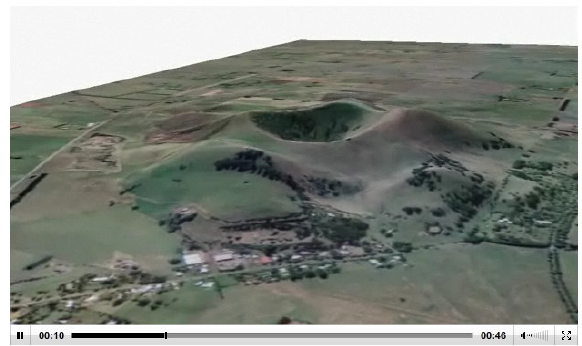
Figure 5. Mt Noorat landscape fly-over